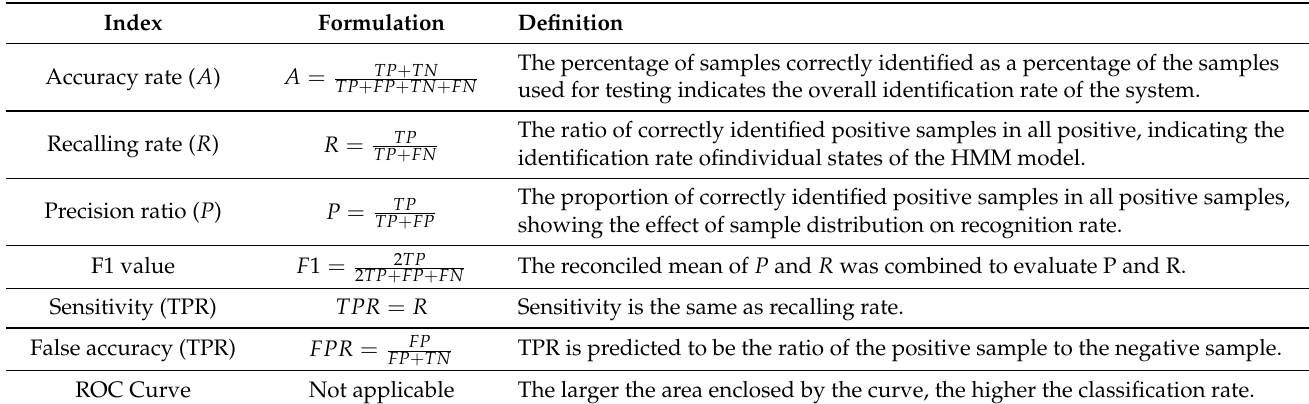
Table 1. Performance evaluation